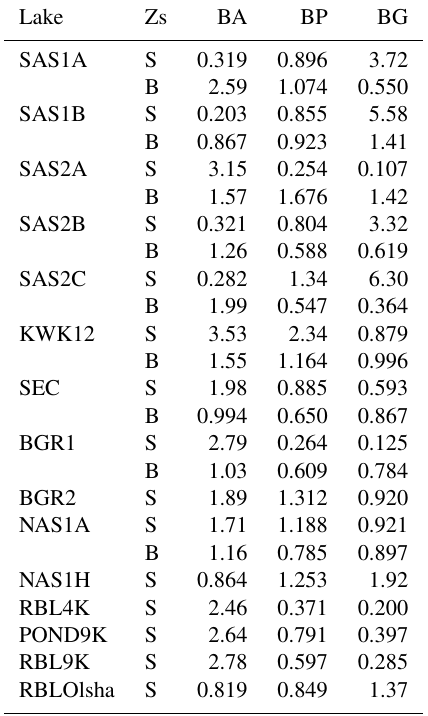
Table 4. Bacterial properties of study sites. Zs, sample depth,